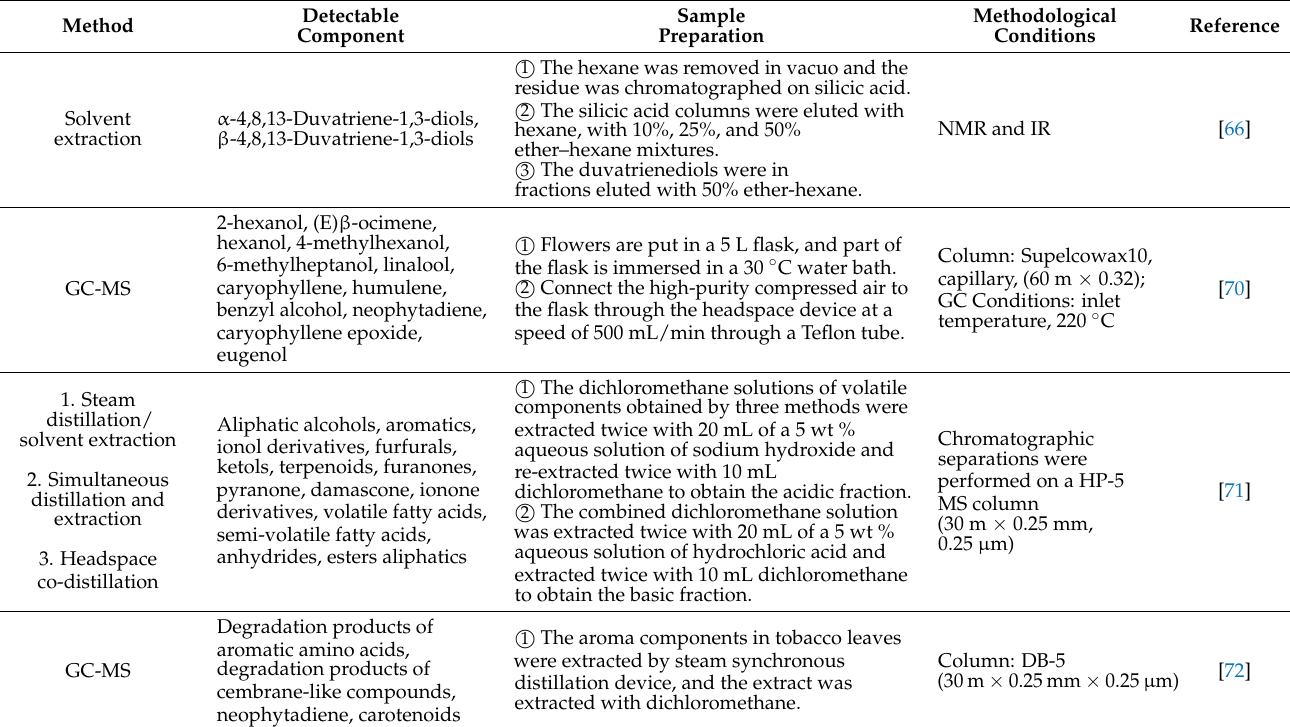
Table 3. Methods for determining cembranoids in tobacco